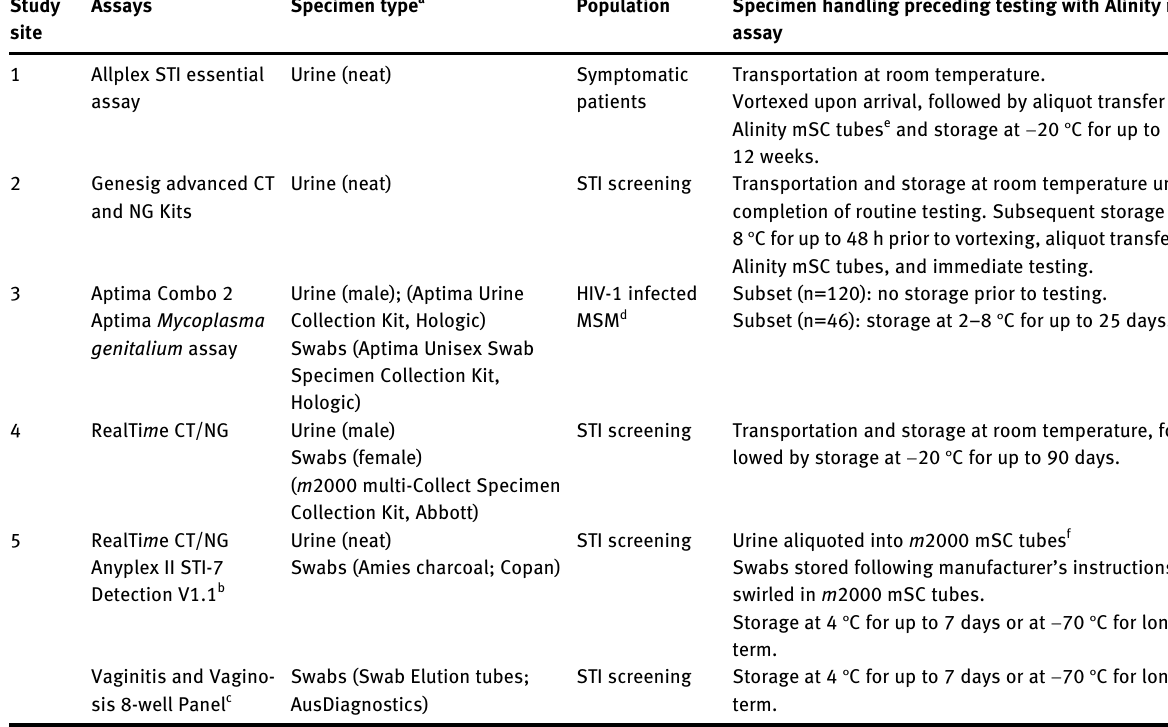
Table  : Molecular diagnostic analyzers and assays used at each study site for clinical specimens. Study Assays Specimen type a Population Specimen handling preceding testing with Alinity m STI site